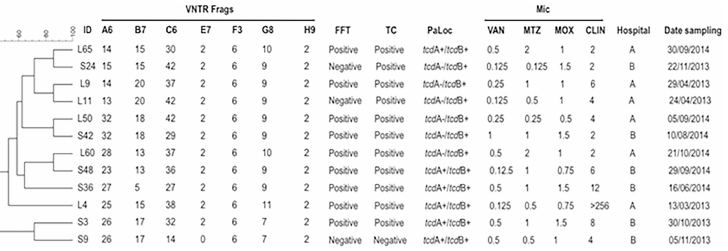
Fig 3. Analysis of ribotype 106 by MLVA. MLVA was applied to 12 isolates belonging to the ribotype 106. Dendrogram showing similarities of banding patterns generated with high-resolution capillary gel-based electrophoresis (CE)-PCR. MLVA clusters are identified by minimum-spanning tree: one clonal complex is defined by MLVA type with less than a two-locus difference. In addition, free fecal toxin A/B (FFT), toxin in cell culture (TC), presence of PaLoc genes ( tcd A/ tcd B), minimal inhibitory concentrations (MIC) for vancomycin (VAN), metronidazole (MTZ), moxifloxacin (MOX) and clindamycin (CLIN) are shown for each isolate with the respective breakpoints. VNTR, variable-number tandem